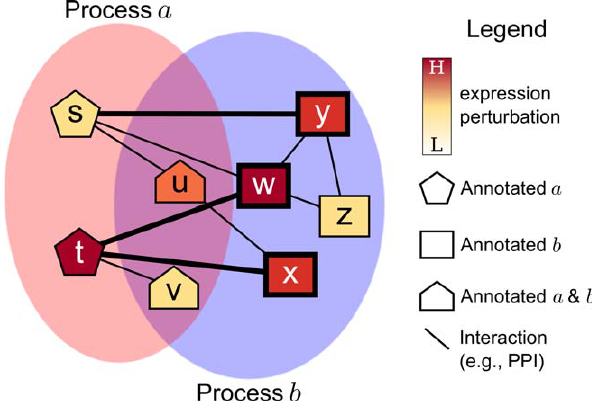
Figure 11. Calculating the links score s ( a , b ) in an example network. Nodes with bold borders (w, x, and y) represent genes in e N ab . Bold edges indicate the interactions contributing to s ( a , b ) .